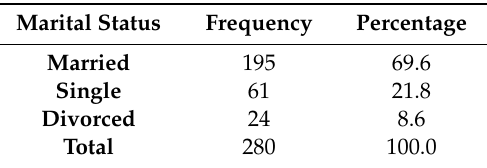
Table 2. Distribution of marital